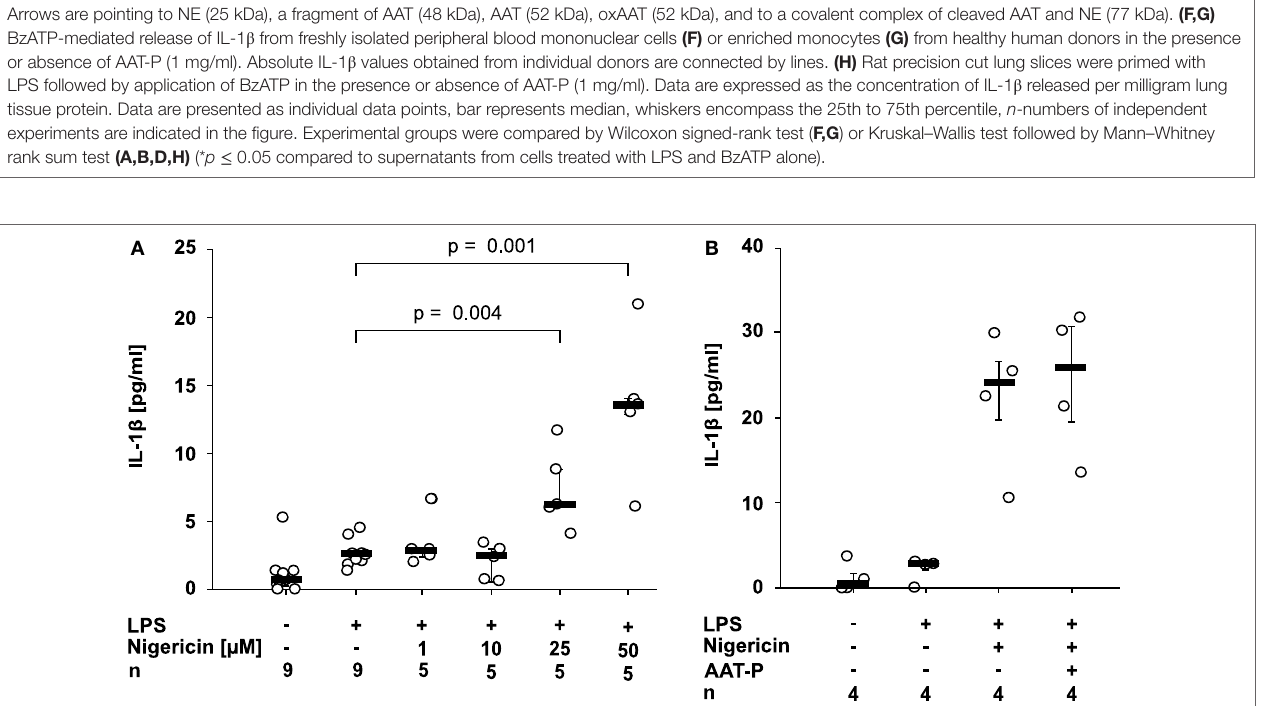
FigUre 2 | Alpha-1 antitrypsin (AAT) does not inhibit the nigericin-induced release of interleukin (IL)-1 β . Human lipopolysaccharide (LPS)-primed monocytic U937 cells were stimulated with different concentrations of nigericin (1–50 µM) in the absence (a) or presence (B) of apyrase (0.5 U/ml) and of the AAT preparation Prolastin ® (AAT-P) (1 mg/ml). IL-1 β released to the supernatant was measured after 30 min. Data are presented as individual data points, bar represents median, whiskers encompass the 25th to 75th percentile, n -numbers of independent experiments are indicated in the figure. Experimental groups were compared by Kruskal–Wallis test followed by Mann–Whitney rank sum test.